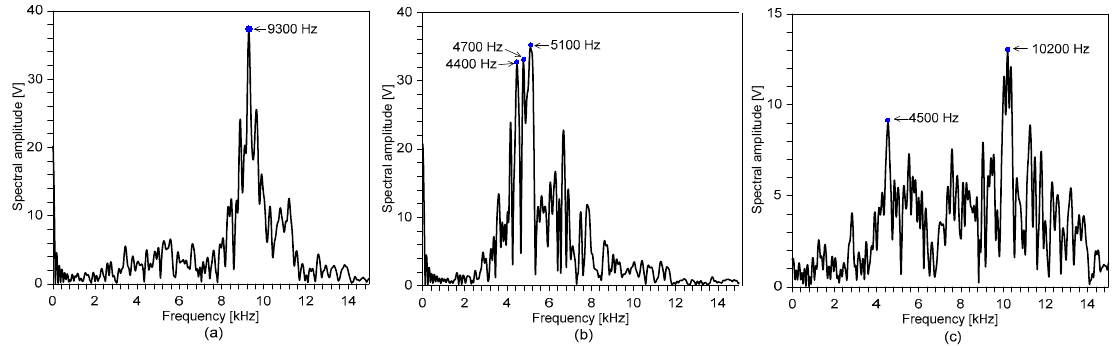
Figure 11. Typical spectral amplitude measured on the reinforced concrete slab specimen before and after the standard fire testing corresponding to the windowed time signals shown in Figure 10a–c.